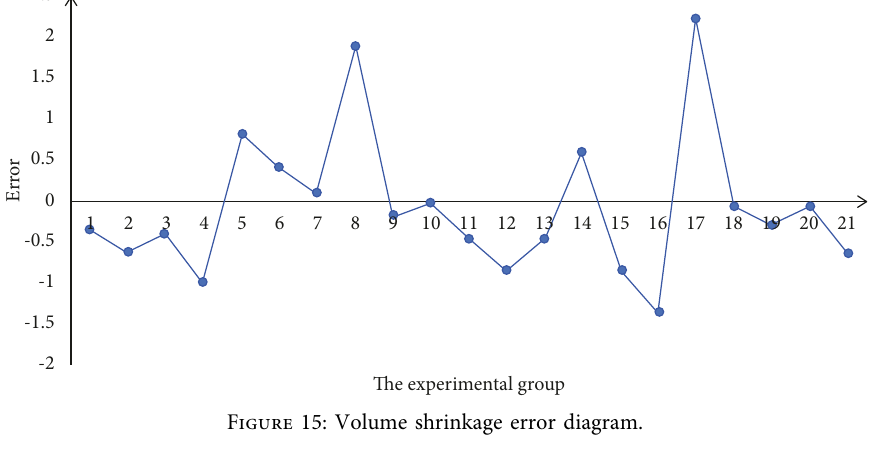
Figure 15: Volume shrinkage error diagram.